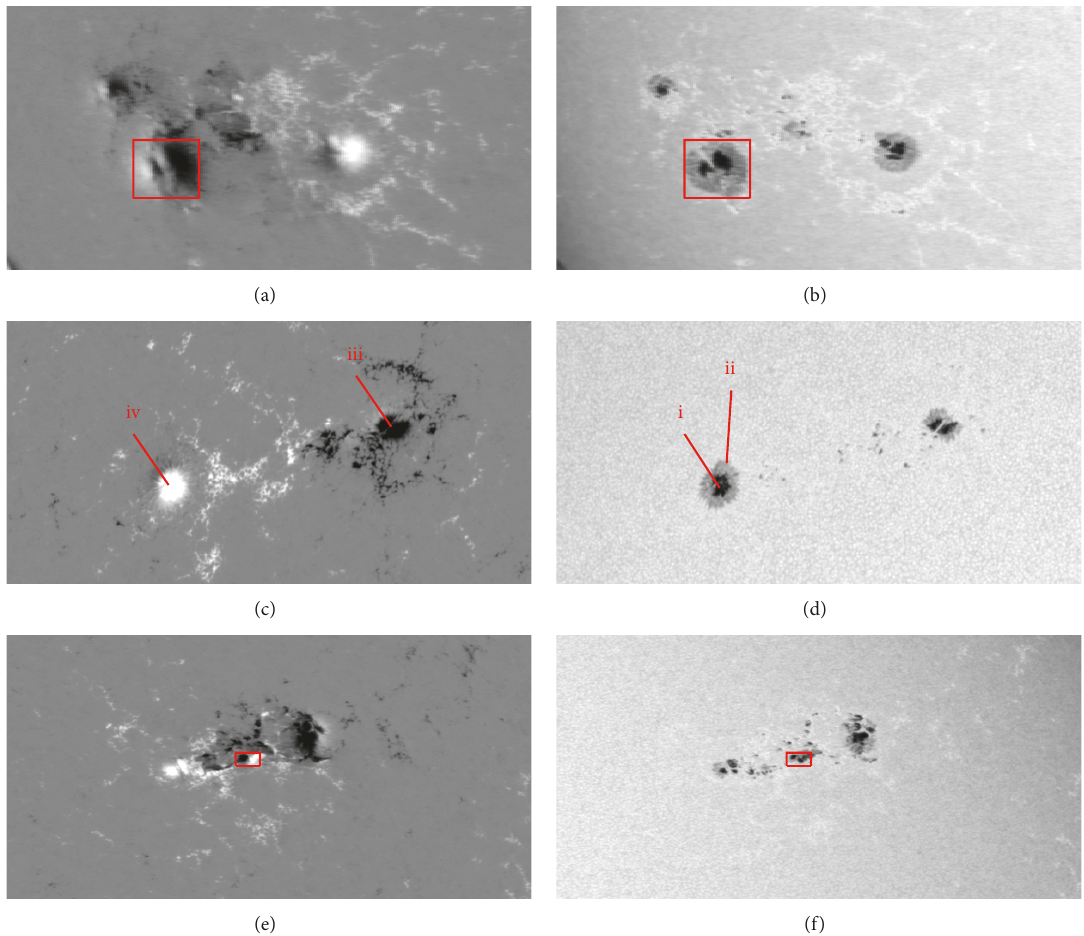
Figure 5: Three cases of misidentification of Beta-x as Beta in model A. (a), (c), and (e) are the magnetograms, whereas (b), (d), and (f) are the continuum images of the same ARs. In continuum images, the dark center is the umbra (i) and a lighter black part around umbra is the penumbra (ii). In magnetograms, the dark areas indicate the negative polarity (iii) region, and the bright areas indicate the positive polarity (iv)